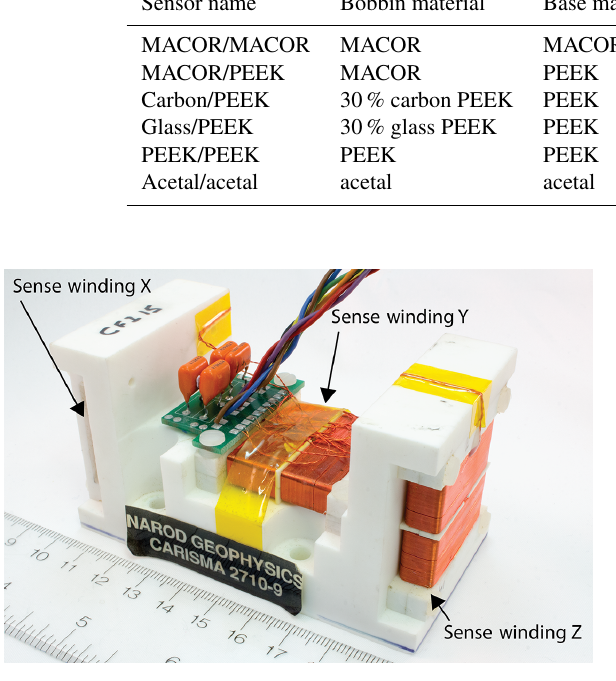
Figure 4. The Narod Geophysics Ltd. STE observatory magne- tometer constructs a measurement of the vector magnetic field from three orthogonal sense windings.